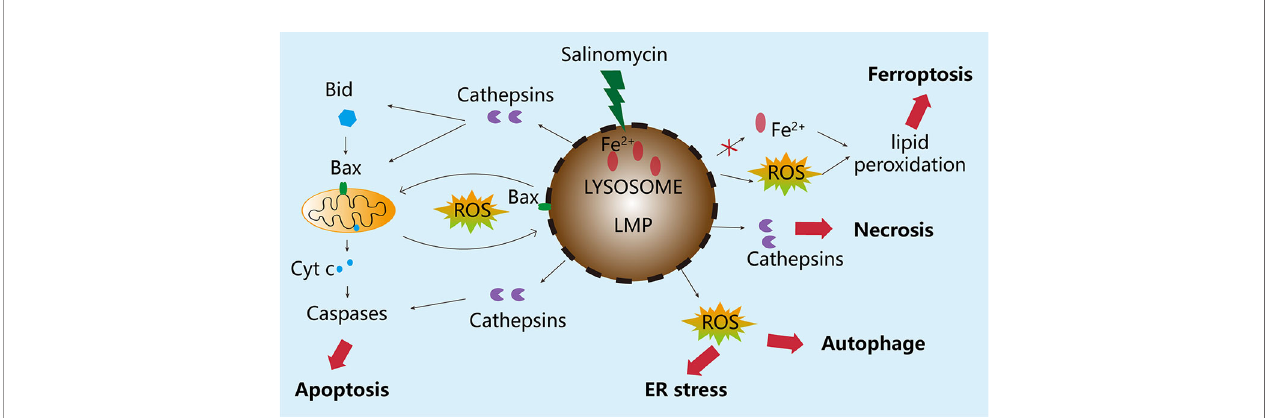
FIGURE 3 | Molecular mechanisms underlying the effects of salinomycin through the lysosomal compartment. Salinomycin is enriched in the lysosome of breast cancer tumor cells, leading to imbalance in Fe+ metabolism, excessive accumulation of Fe ions, and degradation of ferritin, which causes the release of a large amount of free radicals and ultimately induces LMP. Depending on the degree of damage to the lysosome, different responses will be triggered. If the damage to the lysosome is minor, the stress sensor and response mechanisms, including autophagy, will be activated to ensure cell survival. However, when the degree of LMP is very high, the damage cannot be repaired. As a result, special cathepsins will be released from the lysosome into the cytoplasm, causing the disruption of mitochondrial membrane integrity, leading to apoptosis. In the case of severe damage to the lysosome, the release of enzymes from the lysosome can also cause uncontrolled cell death, such as necrosis edit from